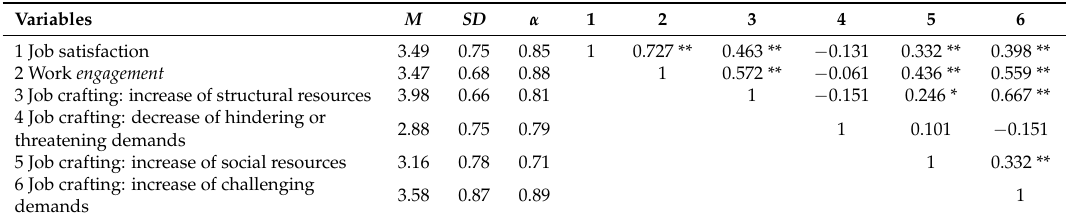
Table 2. Descriptive statistics, reliability, and Pearson’s correlation matrix for study variables (N = 78).